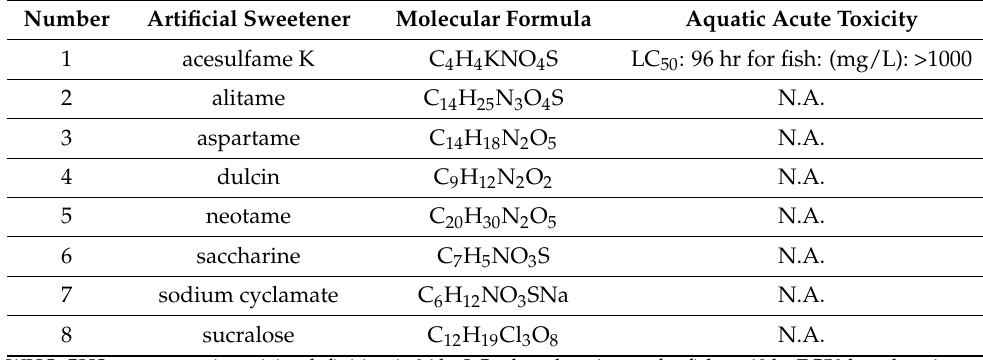
Table 2. Molecular formula and acute toxicity information of the eight artificial sweeteners.